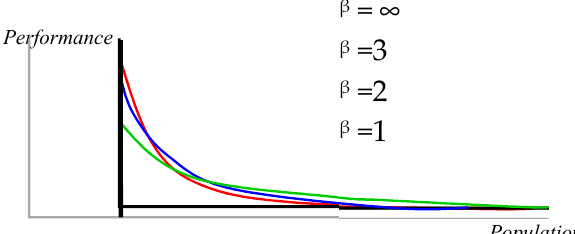
Figure 4. Pareto Approach [38]. Table 1. Pareto